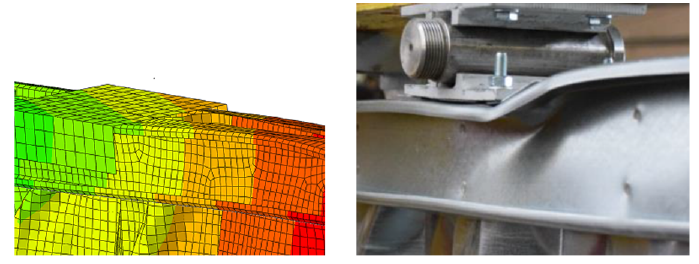
Figure 15. Deformations at the displacement application points.